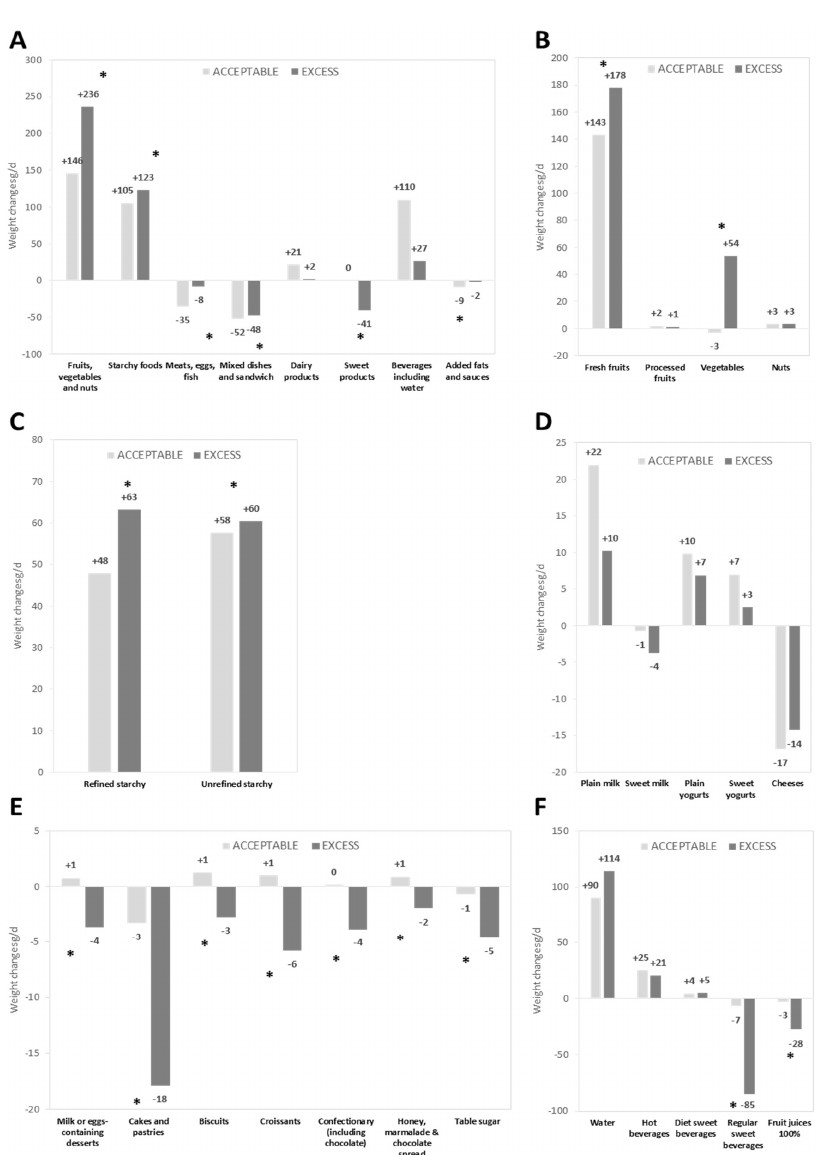
Figure 1. Weight changes 1 between observed and optimized diets (g/day) in food categories ( A ); and in food sub ‐ categories for: fruits/vegetables/nuts ( B ); starchy foods ( C ); dairy products ( D ); sweet products ( E ); and beverages including water ( F ), in FS ‐ ACCEPTABLE and FS ‐ EXCESS individuals 2 . 1 Italic and bold values indicate a weight change significantly different from zero adjusted for age, gender, energy intake, smoker status, BMI, socio ‐ professional status, composition of the family and sitting time; 2 the * symbol means that the weight changes were significantly different between FS ‐ ACCEPTABLE and FS ‐ EXCESS groups, adjusted for age, gender, energy intake, smoker status, BMI, socio ‐ professional status, composition of the family and sitting time.